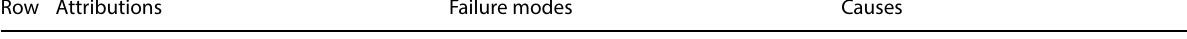
Table 2 Potential failure modes and their causes Row Attributions Failure